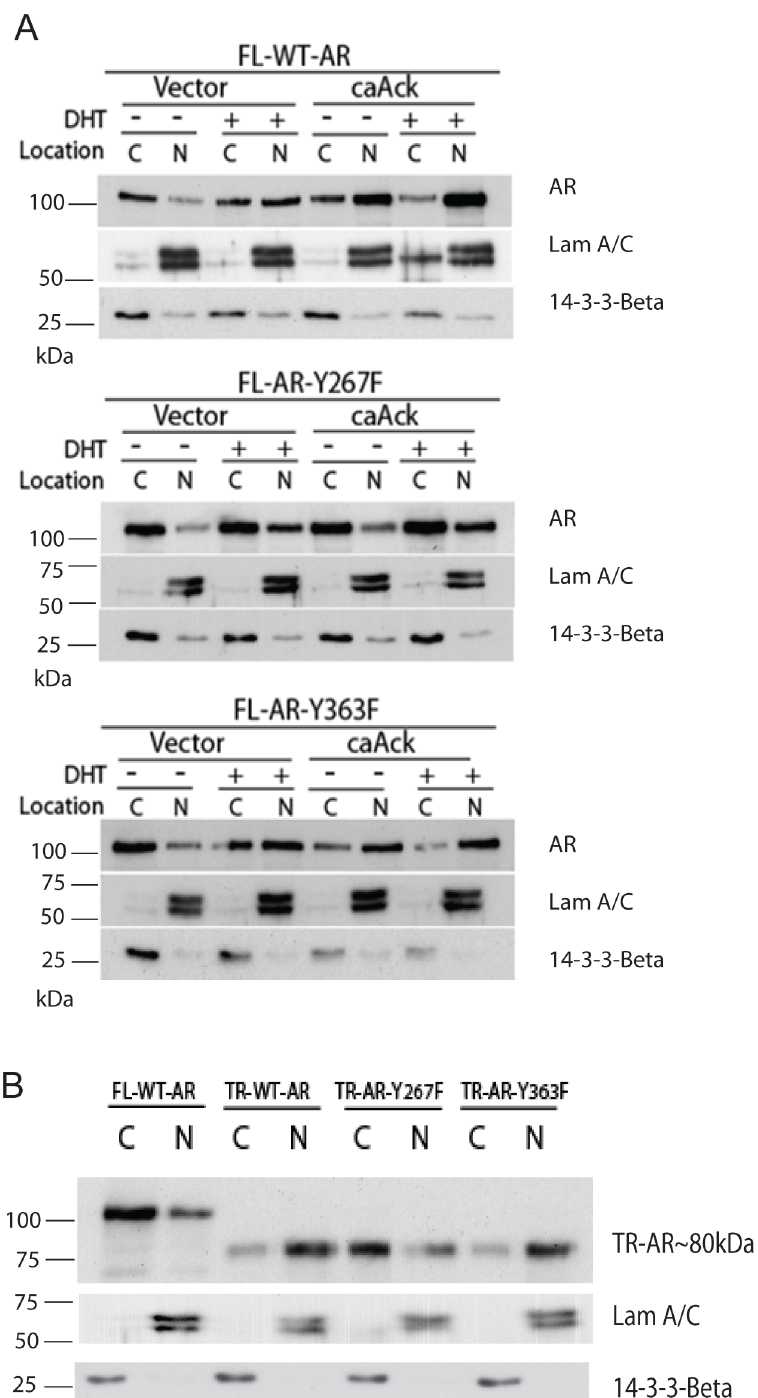
Fig 5. The AR Y267F mutant is defective in androgen- and Ack1-induced nuclear translocation. (A) COS-7 cells were transfected with the AR expression vector and the constitutively active Ack1 L487F expression vector [22] and incubated for 48 hrs. The cells were serum-starved overnight and treated with or without DHT (10 nM) for 2 hrs. Subcellular fractionation was performed. Fifteen μ grams of protein from cytoplasmic (C) and nuclear (N) fractions were immunoblotted with the AR antibody. Laminin A/C and 14-3-3 β were used as markers of nuclear and cytoplasmic fractions, respectively. (B) COS-7 cells were